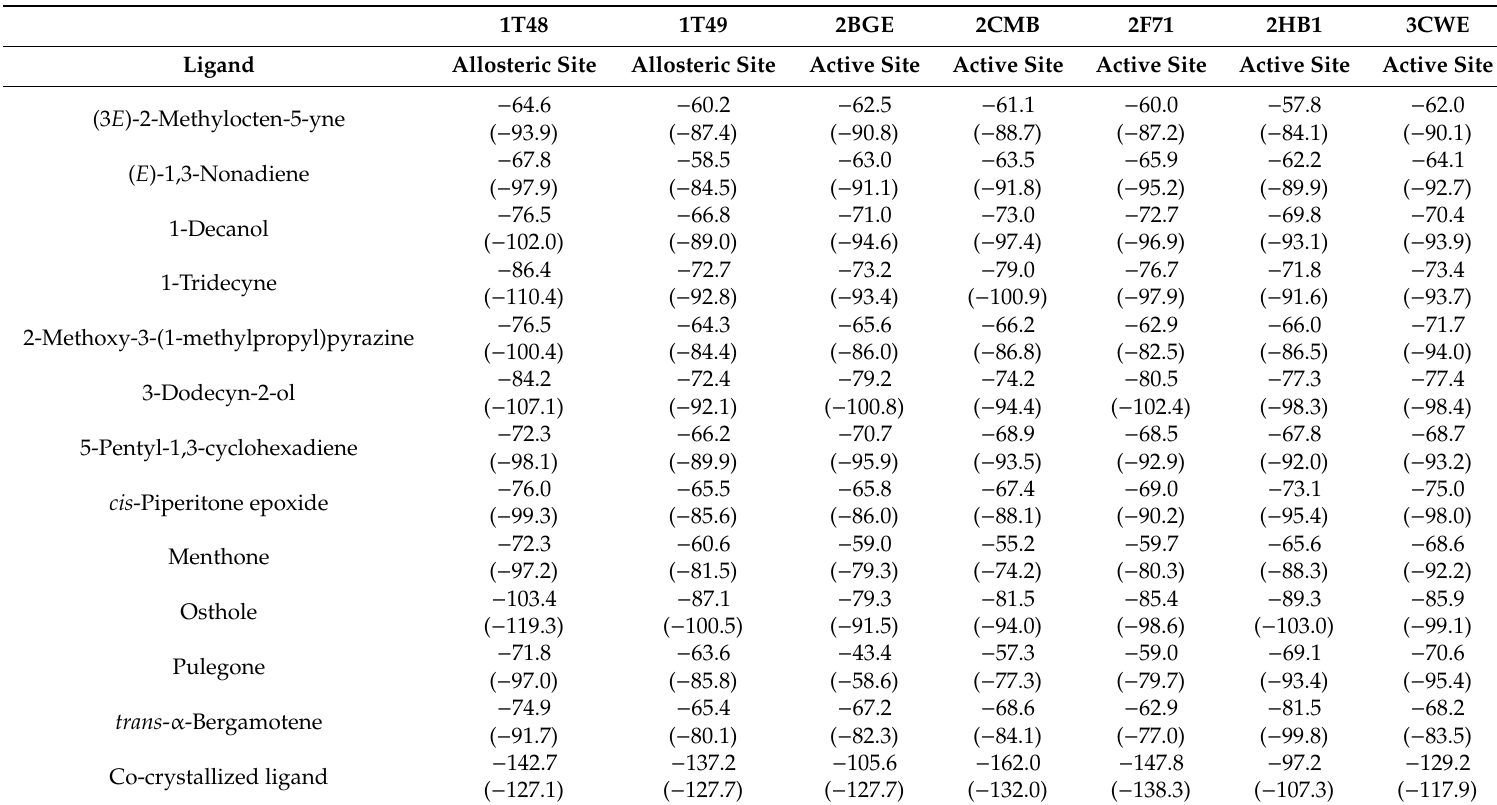
Table 3. MolDock “rerank” docking energies (kJ / mol) and molecular-weight-scaled docking energies (in parentheses) for Prangos pabularia root essential oil major components with human